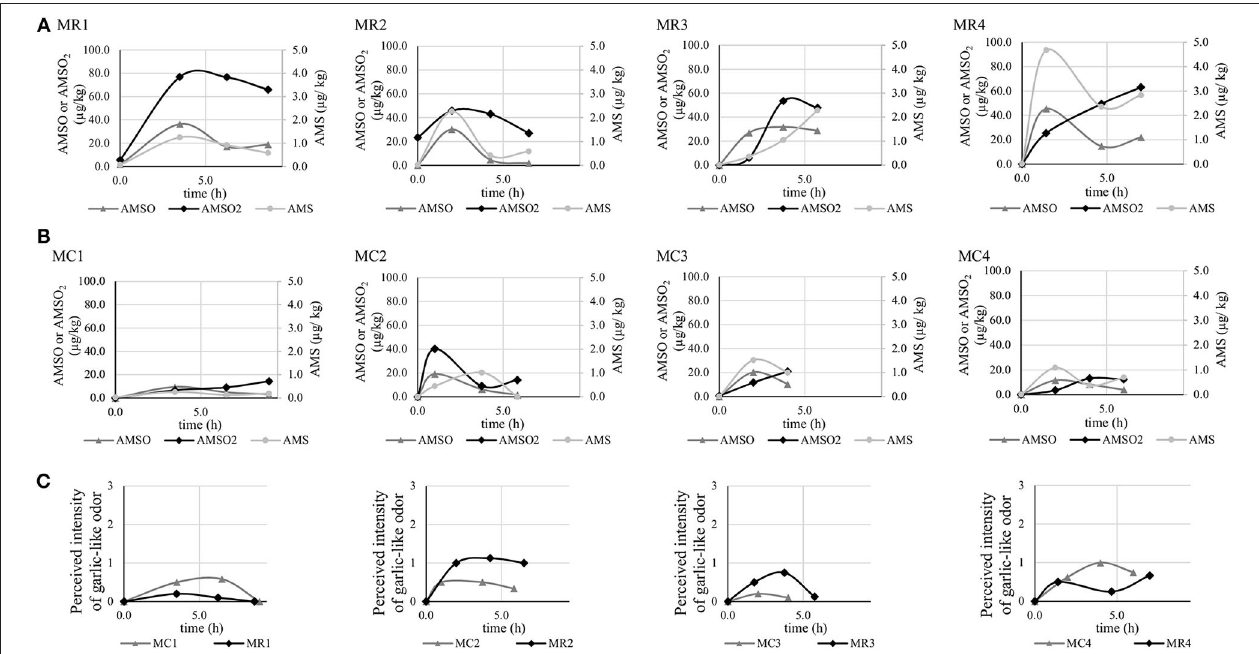
FIGURE 4 | Concentrations (in µ g/kg) of garlic metabolites AMS, AMSO, and AMSO 2 detected in milk collected before and after ingestion of roasted (A) and cooked (B) garlic in 4 participants. Perceived intensity of a garlic-like odor in the milk samples (C)